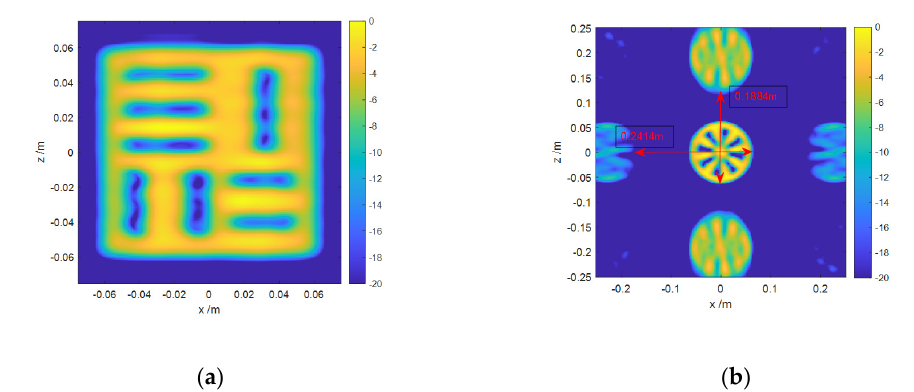
Figure 9. Imaging results of different models: ( a ) 2D imaging result of a slab square; ( b ) 2D imaging result of a Siemens Star.